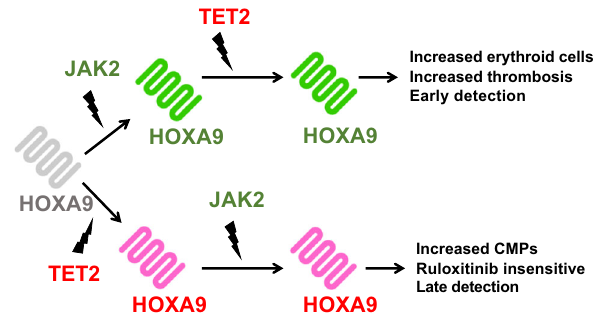
Fig.1|Temporalmutationorderhasclinicalimplicationsinmyeloproliferative neoplasms. CMPs:commonmyeloidprogenitors.BothofthegenesJAK2andTET2 are mutated in myeloproliferative neoplasms, but different orders of the mutation canleadtodistinctchangesinthecelltypesthatexpand,drugsensitivity,andtime of presentation in the